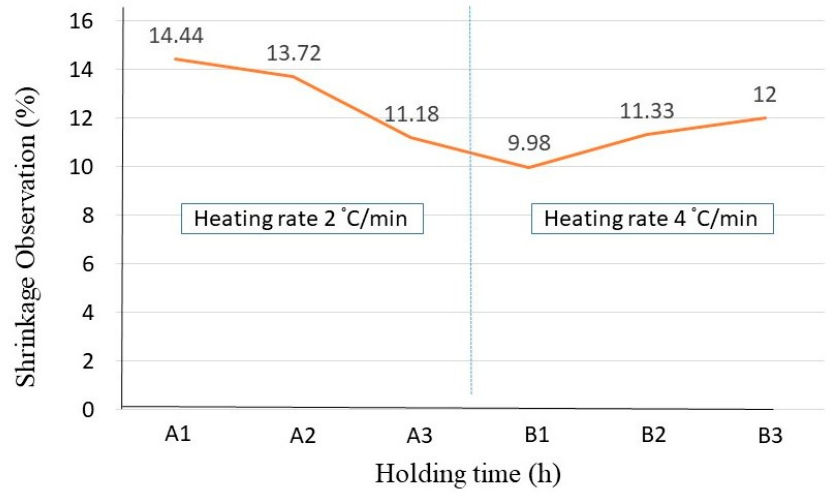
Figure 3. Shrinkage observation on different holding times (1:1 h, 2:2 h, and 3:3 h) and heating rates.